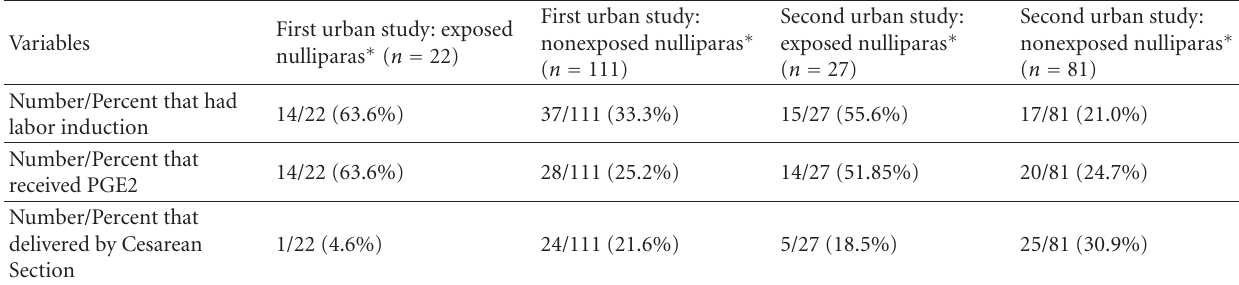
Table 1: Summary table of Nulliparous patients ∗ in the two completed Urban Studies [4,